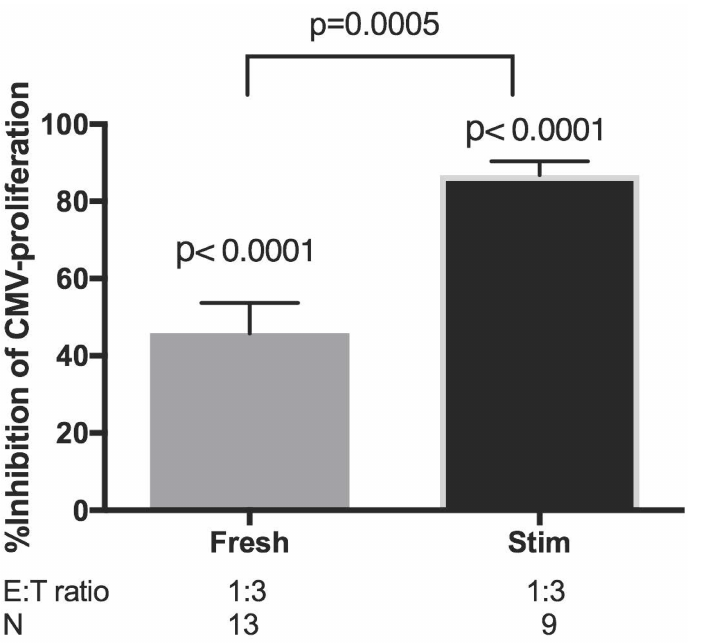
Fig 4. Functional evaluation of peripheral blood CD4+CD27-CD28- (Fresh) with ex vivo CMV- restimulated CD4+CD27-CD28-(Stim) T cells from CMV-seropositive donors. Bars represent means and SEM of % inhibitionof proliferation calculatedby the followingformula: [(median CPM of CMV-stimulated wells) -(medianCPM of CMV-stimulated + Treg wells)]/(median CPM of CMV-stimulated wells) x 100. E: T = Treg to autologous PBMC ratio. N = numberof donors. P values above each column were calculatedby singlesample T test comparedwith 0% inhibition.P value between columnswas calculatedby unpairedT test. S3 Fig shows the same data presentedin